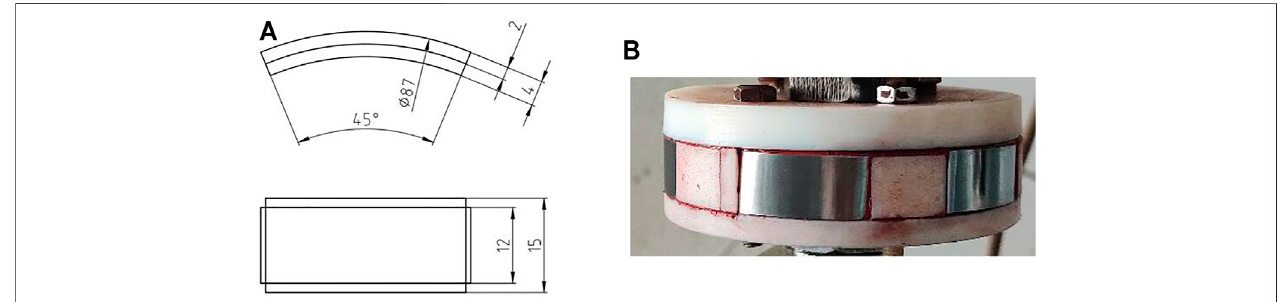
FIGURE 3 | (A) sample size of N80 steel for corrosion experiments and (B) rotating cage after samples mounted(unit:mm).